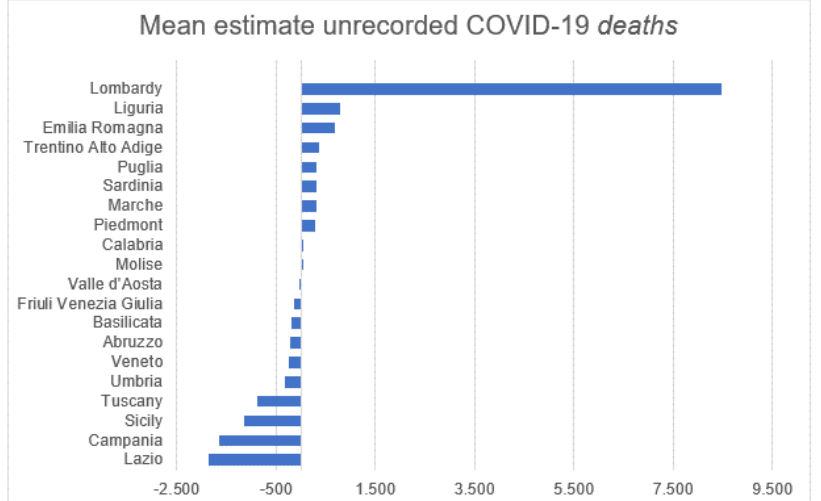
Figure 19. Histogram of the calculated mean estimates of unrecorded COVID-19 deaths in the Italian’s regions. Negative values are present in cases where the values of officially registered COVID-19 deaths exceeds the mean value of excess deaths estimated for the region.